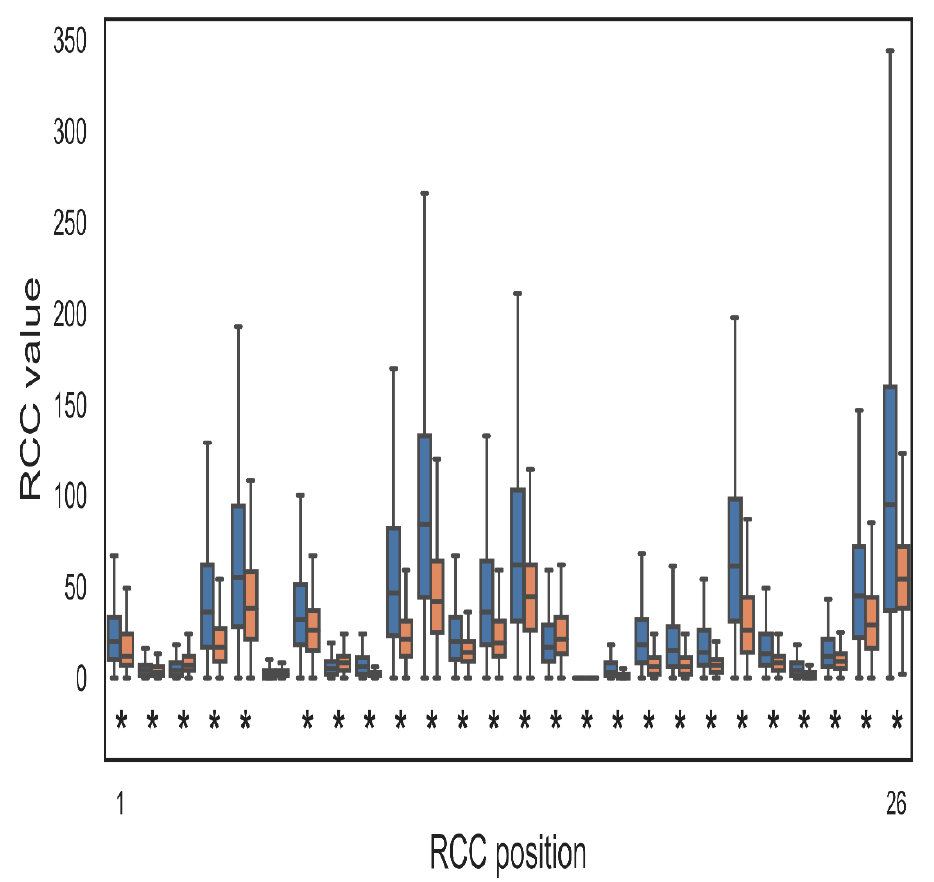
Figure 6. Comparison of positive and negative PPI through RCC. The image shows a representative